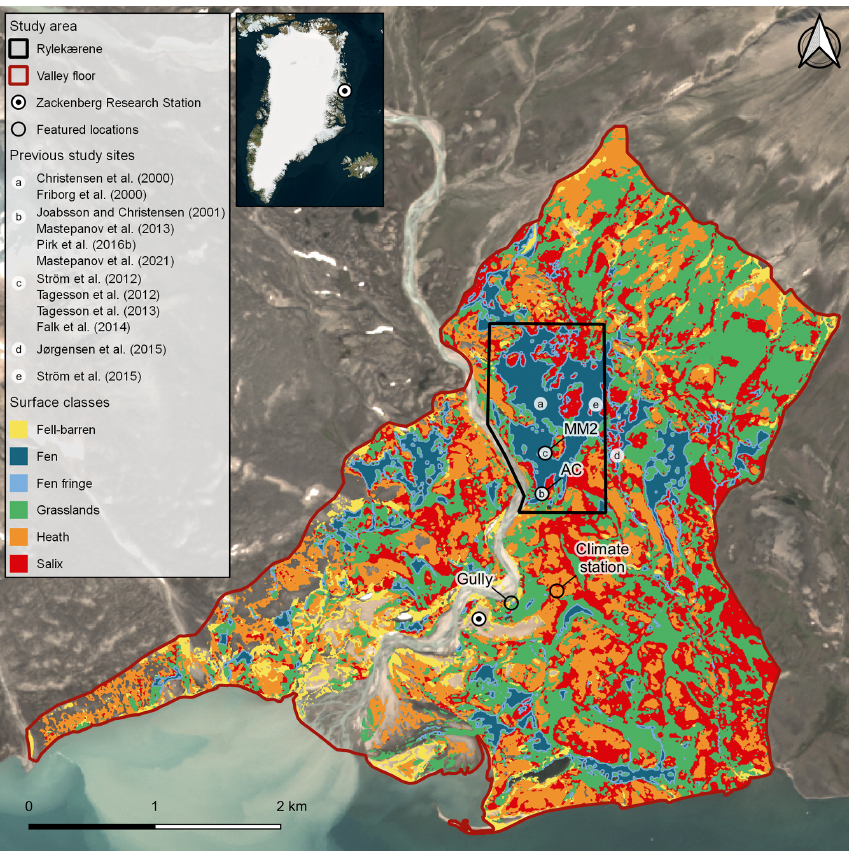
Figure 1. The study area with dark red and black boundaries showing the valley floor study area and Rylekærene in Zackenberg Valley (74.47 ◦ N, 20.55 ◦ W) and approximate locations of previous study sites are marked with letters. The two gas flux monitoring sites, AC and MM2, are found at the same places as study sites b and c, marked with black circles. Colored areas show the spatial distribution of the six surface classes used in this study. Data sources: HyMap hyperspectral imaging campaign (7 August 2000) (Elberling et al., 2008), ESA Copernicus Sentinel-2 (16 July 2019), and © BING Maps